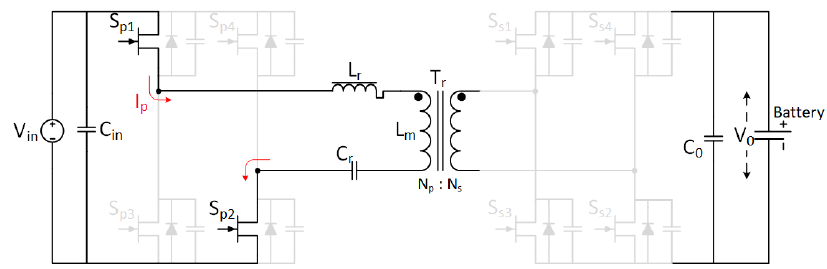
Figure A3. LLC resonant converter topology interval-3.